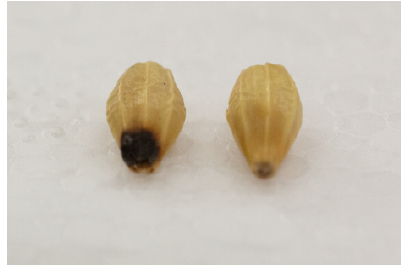
Figure 1. Killed ( left ) and live ( right ) wheat seeds. In the killed seed, the embryo was killed using a soldering